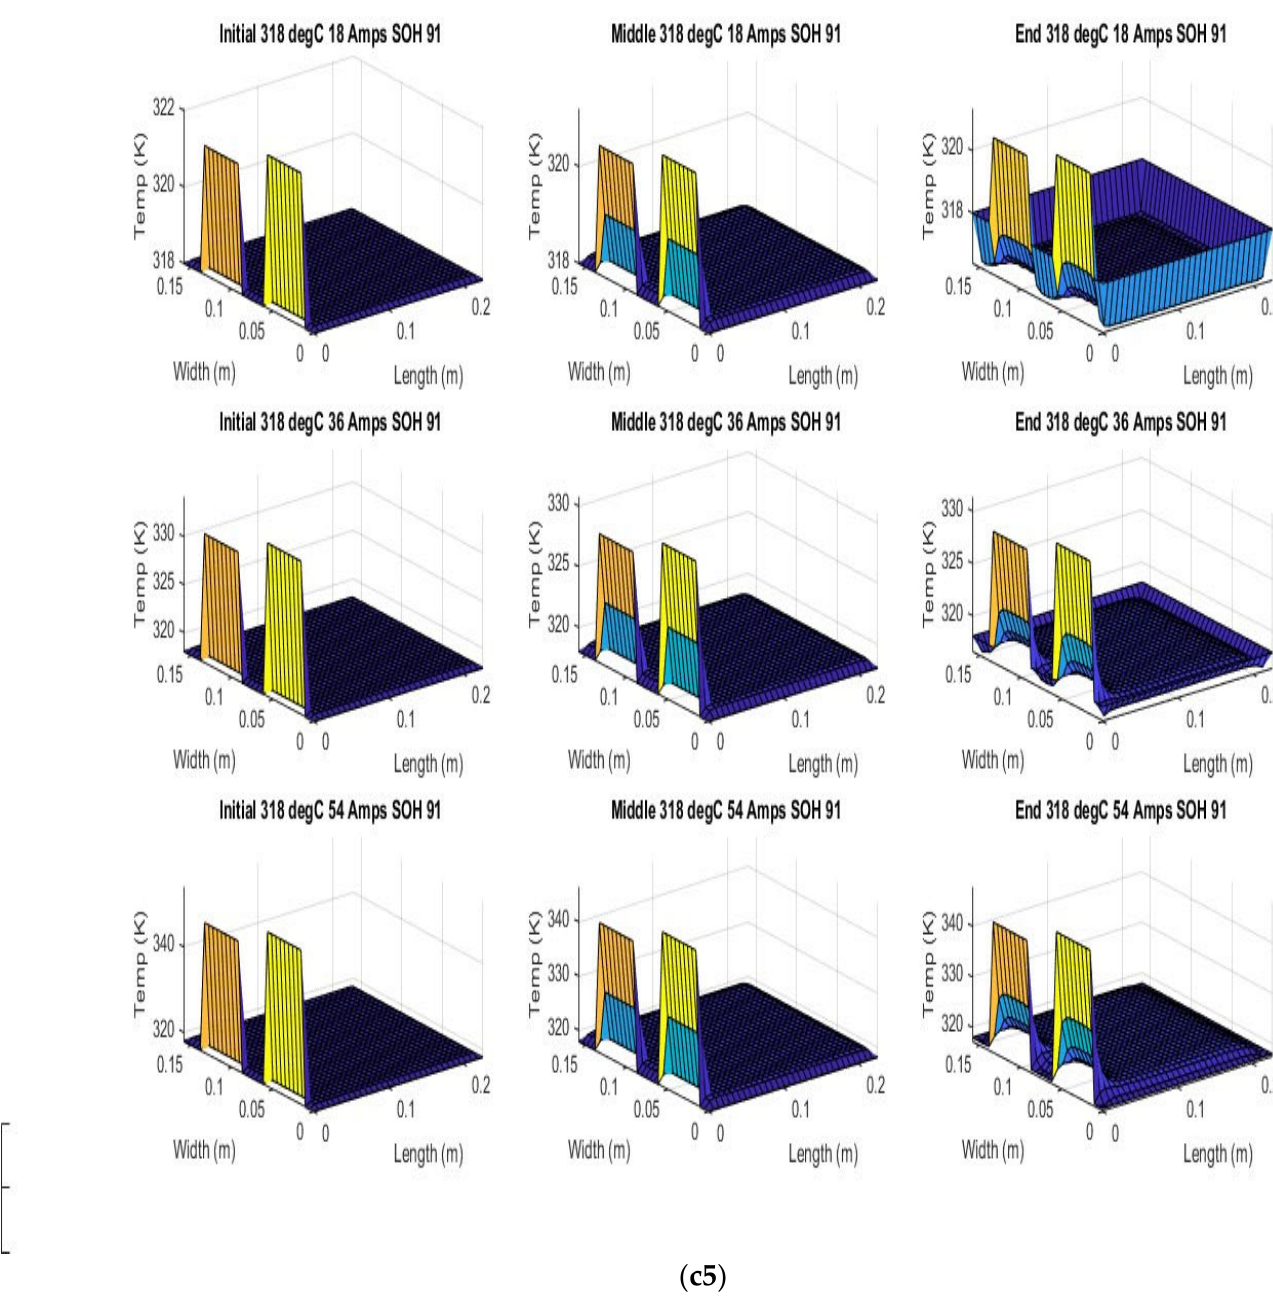
Figure 7. Surface Temperatures (K) Produced by 2D model for all 45 Experimental Temperatures, SOHs and C rates. ( a ) Initial, middle and end Surface Temperatures for SOH 65% at 278 K, 288 K, 298 K, 308 K, 318 K for 1C, 2C, 3C C-rates (Highest Accuracy Model at SOH 65% highlighted). ( b ) Initial, middle and end Surface Temperatures for SOH 83% at 278 K, 288 K, 298 K, 308 K, and 318 K for 1C, 2C, and 3C C-rates (Highest Accuracy Model at SOH 83% highlighted). ( c ) Initial, middle and end Surface Temperatures for SOH 91% at 278 K, 288 K, 298 K, 308 K, and 318 K for 1C, 2C, and 3C C-rates (Highest Accuracy of all 45 Runs Highlighted).